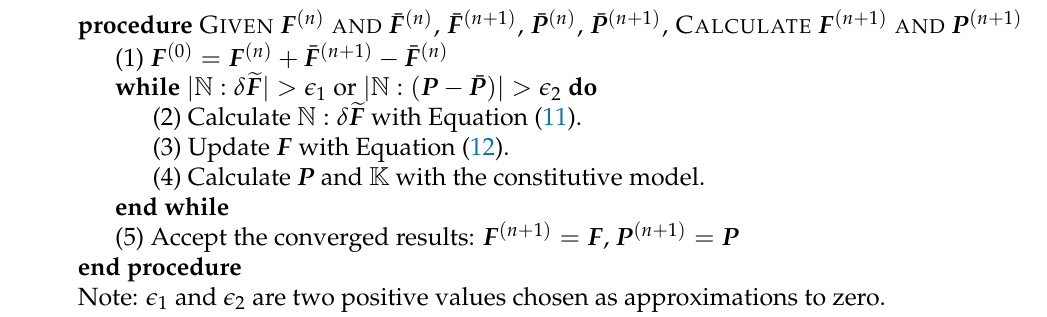
Algorithm 1 Iteration in the stress and mixed control single-point